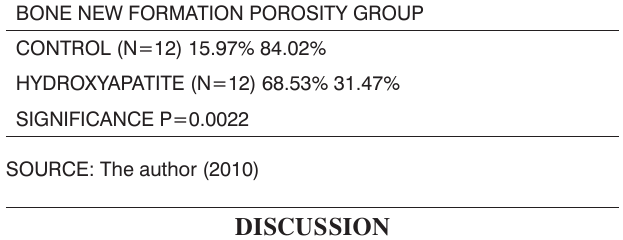
Figure 5. Histological analysis of the hydroxyapatite group.